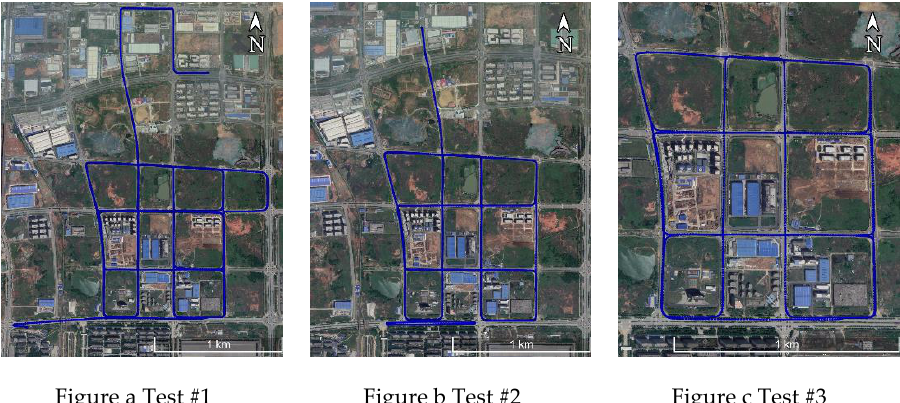
Figure 6. Test trajectory in the open-sky environment.